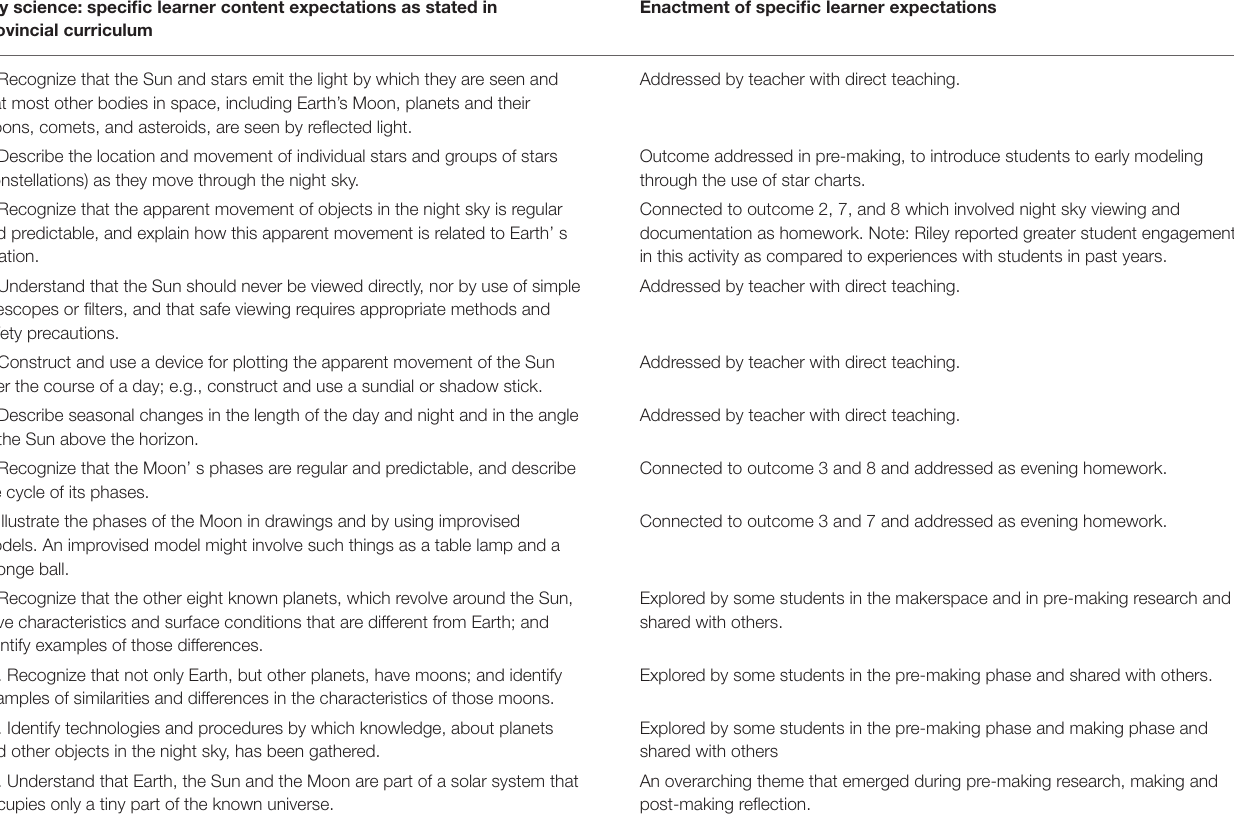
Enactment of specific learner